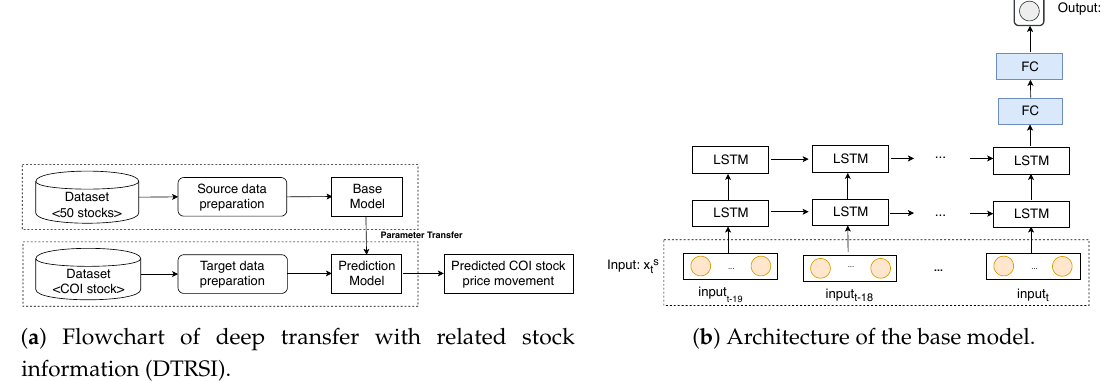
Figure 3. The framework and the model